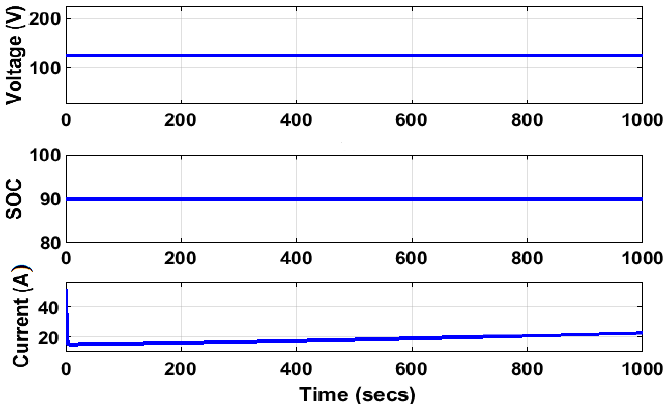
Figure 8. Performance analysis of voltage, SOC, and current waveforms for electric vehicles.